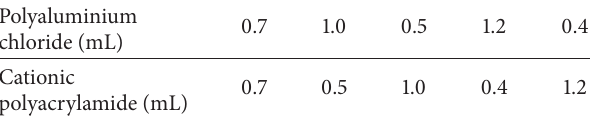
Table 2: The dose of combination of two